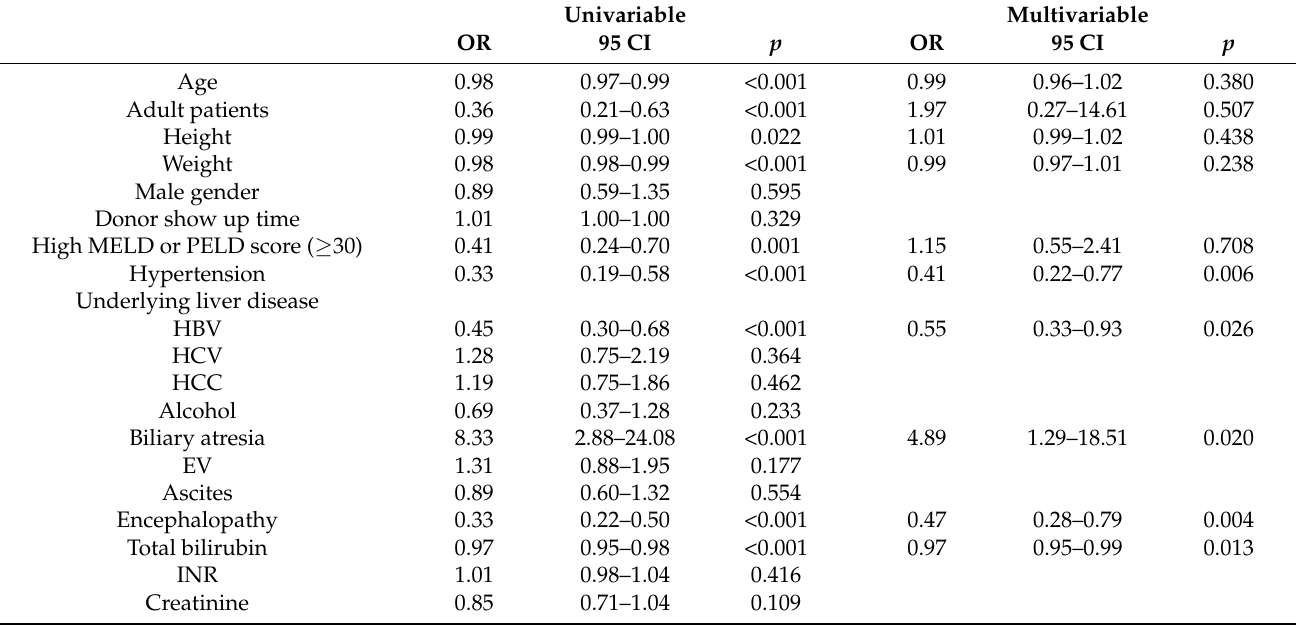
Table 2. Factors associated with successful live liver donation in univariable and multivariable analyses. Patients who received deceased donor liver transplant were